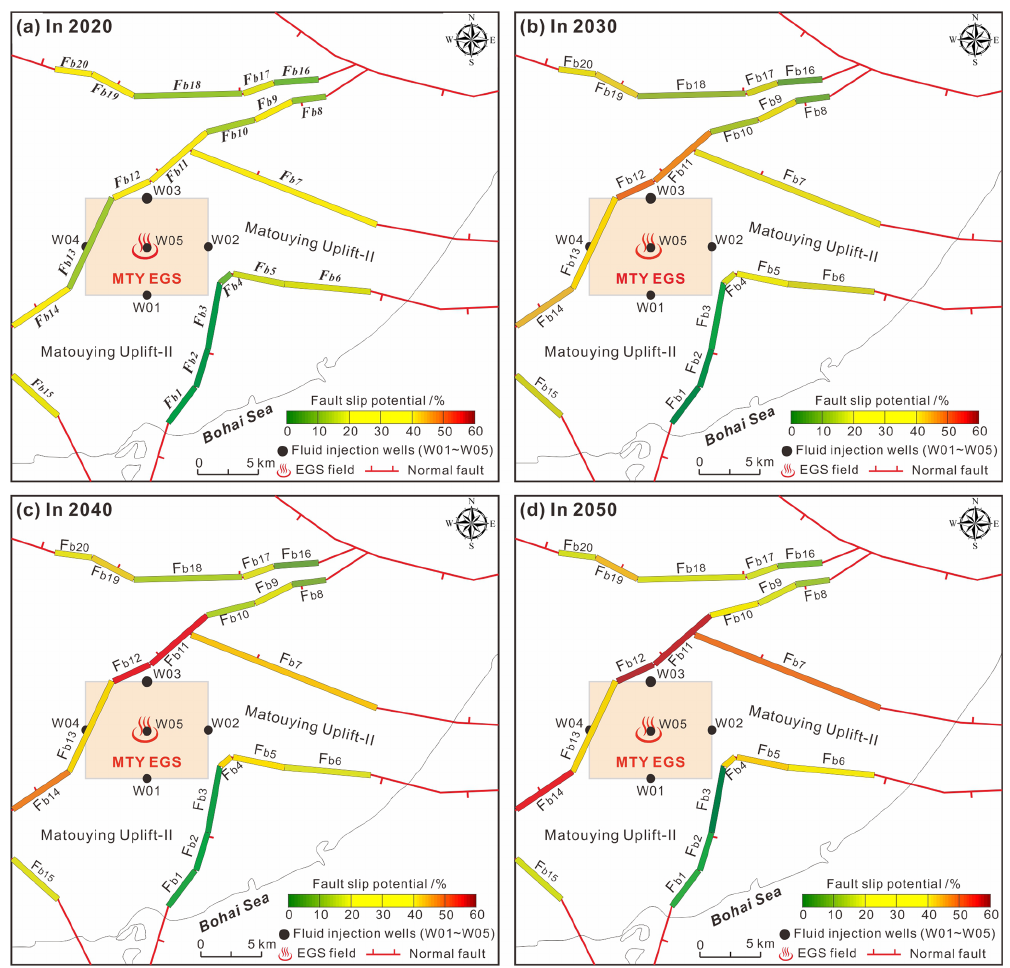
Figure 12. The probabilistic fault slip potential on the mapped faults within a range of ∼ 15–20km away from the MTY EGS field in response to the hypothetic fluid injection in 2020 (a) , 2030 (b) , 2040 (c) , and 2050 (d)